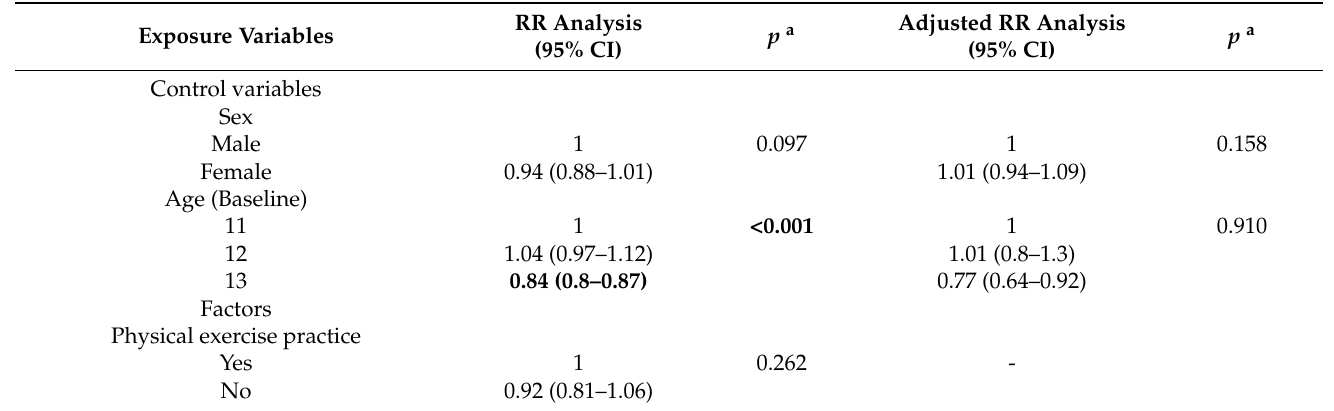
Table 3. Association between back pain (outcome) and exposure factors (physical exercise, hereditary, behavioral, and postural